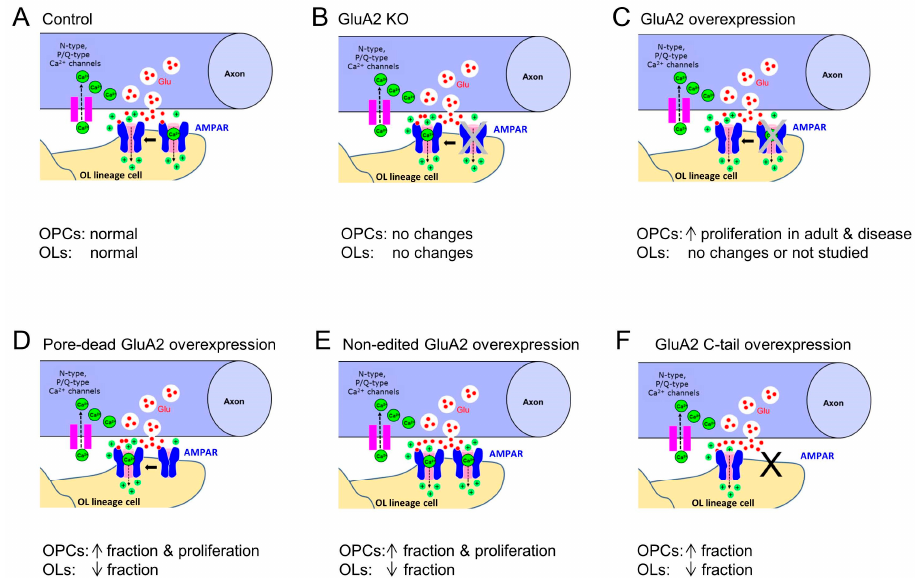
Figure 2. Brief summary of approaches used to study functional role of GluA2-containing AMPARs in the OL lineage cells and the corresponding experimental findings: ( A ) control; ( B ) knockout (KO) of GluA2 subunit in Sox10 + -cells [15] ; ( C ) overexpression of GluA2 subunit in OL lineage cells using different mouse lines [36] ; ( D ) overexpression of pore-dead GluA2 subunit in proliferating callosal OPCs using retroviral gene delivery approach in vivo [13] ; ( E ) overexpression of non-edited GluA2 subunit in proliferating callosal OPCs using retroviral gene delivery approach in vivo [13] ; and ( F ) overexpression of GluA2 C-tail in proliferating callosal OPCs using retroviral gene delivery approach in vivo [13]. Red dots indicate glutamate molecules; green dots with the sign “+” indicate monovalent cations.